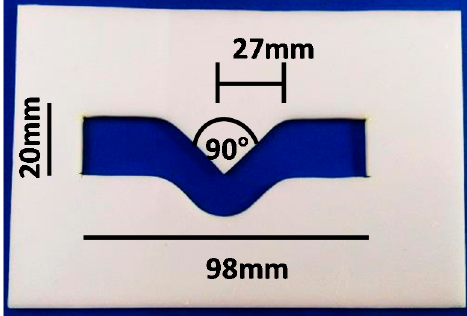
Figure 2. Mold used for tear strength test.